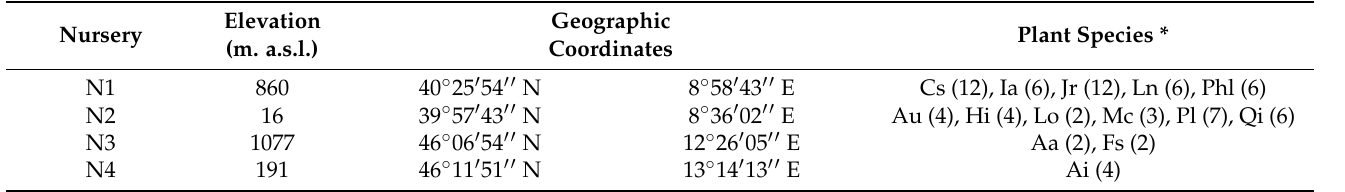
Table 1. Nurseries information and plant species monitored for Phytophthora .